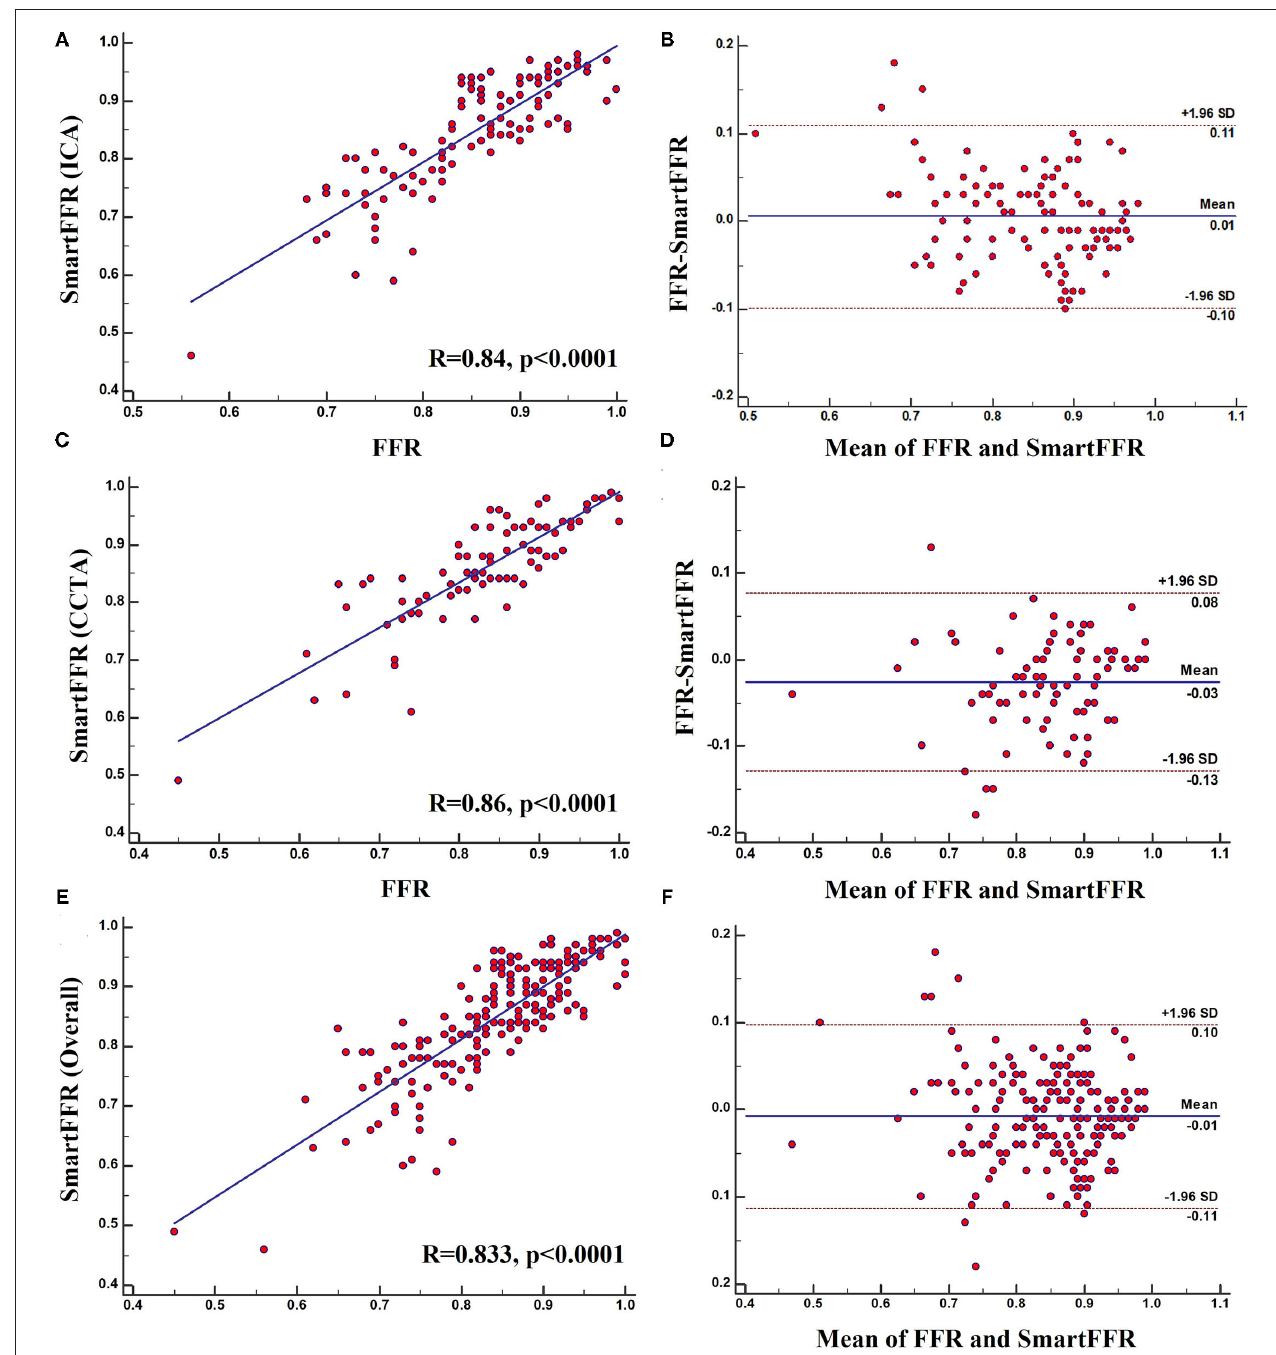
FIGURE 5 | (A) Regression plot and (B) Bland-Altman plot comparing SmartFFR to the invasively measured FFR (ICA Dataset). (C) Regression plot and (D) Bland-Altman plot comparing SmartFFR to the invasively measured FFR (CTCA Dataset). (E) Regression plot and (F) Bland-Altman plot comparing SmartFFR to the invasively measured FFR (Overall